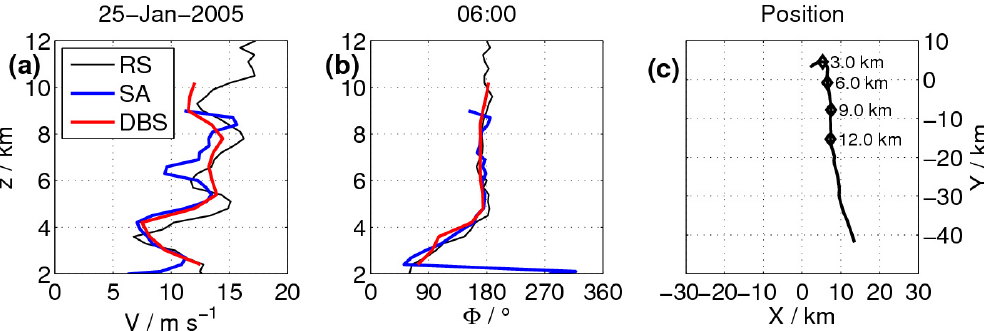
Fig. 1. Comparison of typical height profiles from radiosonde (RS) and radar soundings (DBS and SA). Wind speed (a) and wind direction (b) are shown for the three methods as well as the trajectory of the radiosonde (c) which shows the distance to the ALWIN VHF radar.